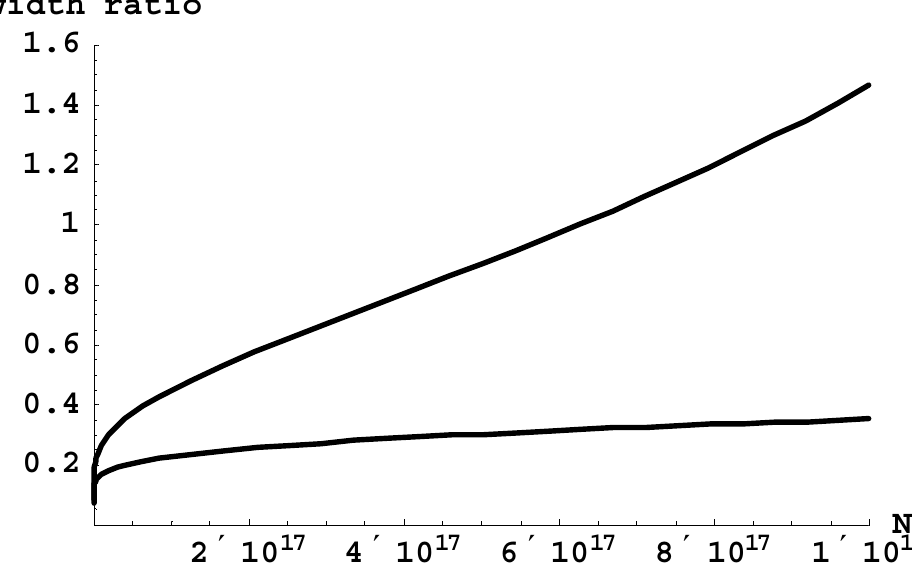
Figure 20. The ratio γ αβ ,hel / γ αβ ,rec from Equation (10.47) versus the electron density N e for the range of N e relevant to the DA white dwarfs at T e = 1 eV. The lower curve is for the Lyman-alpha line. The upper curve is for the Balmer-beta line—specifically for its two intense π -components of |X αβ | = 10 [101].